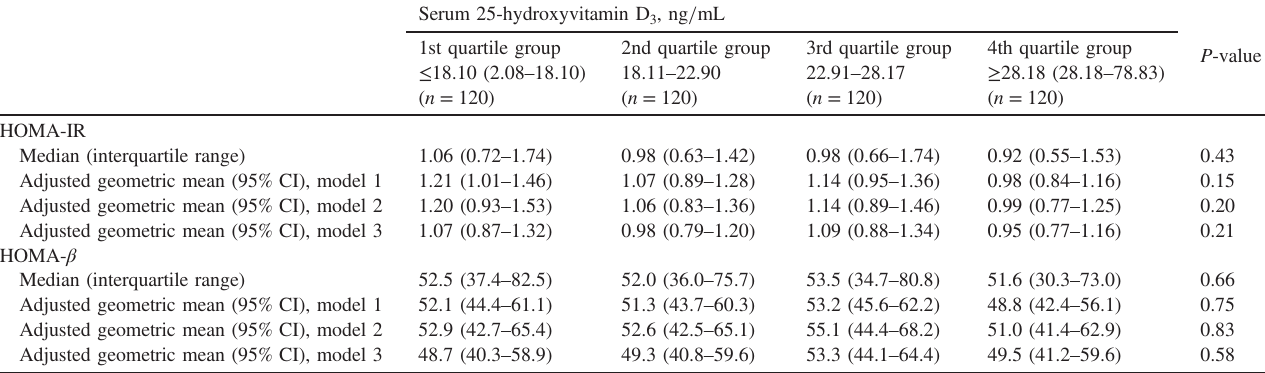
Table 3. Median and geometric means of HOMA-IR and HOMA- β in participants grouped by serum 25-hydroxyvitamin D 3